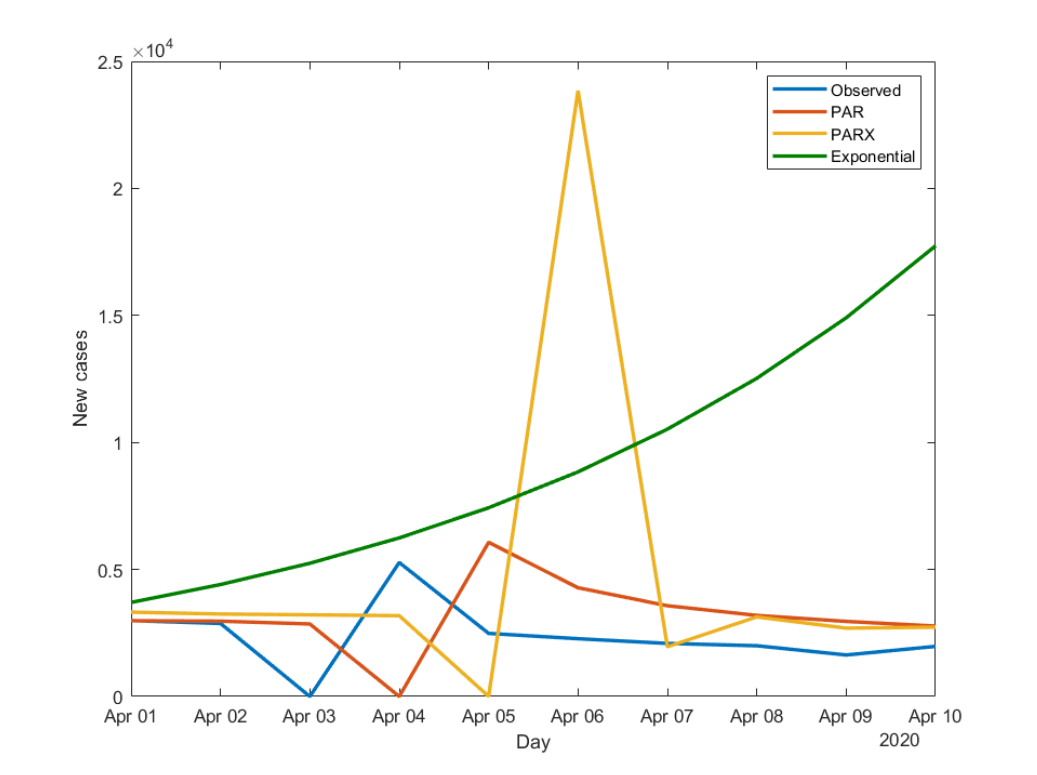
Figure 4. Daily infection counts in Iran: observed and predicted values.